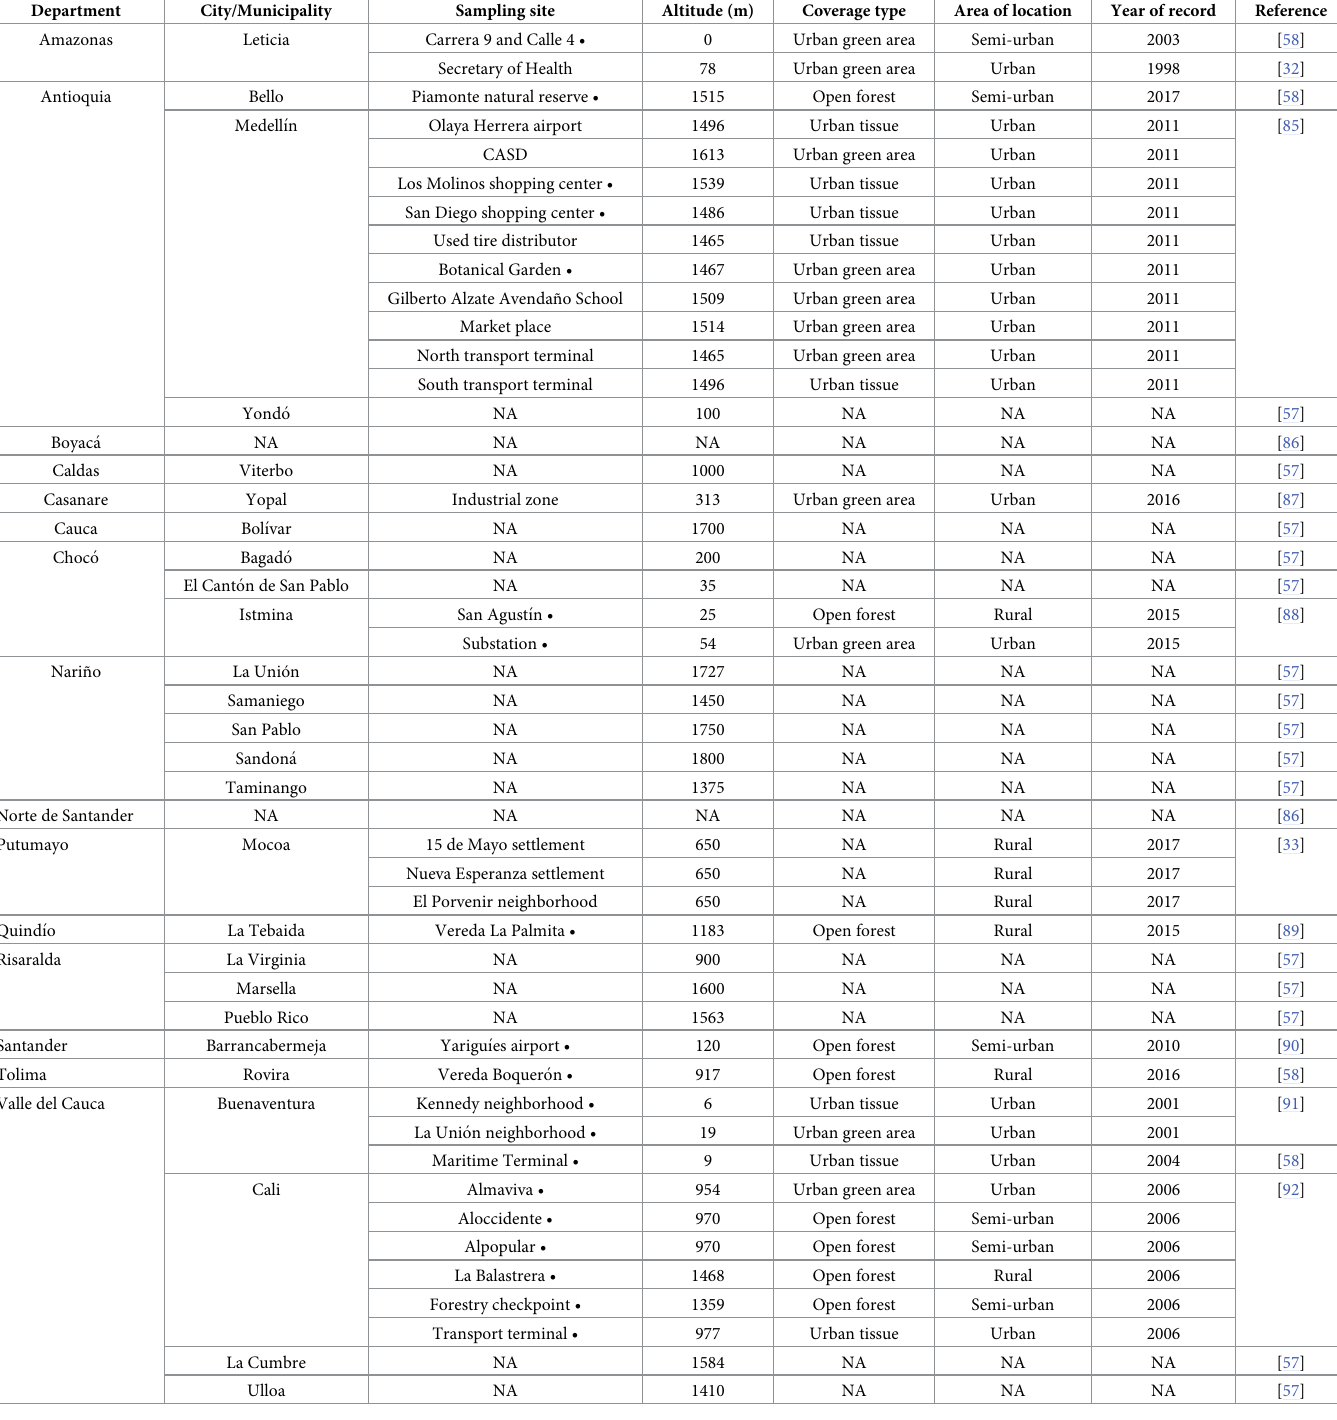
Table 1. Records of Aedes albopictus in Colombia and its border limits.